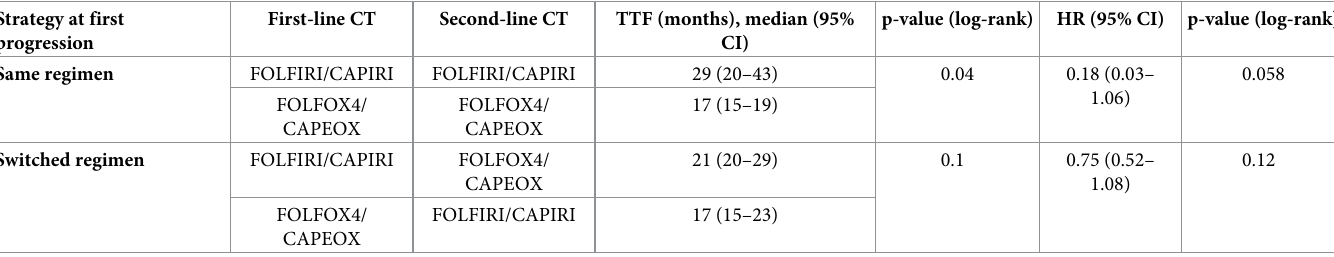
Table 5. Time to treatment failure according to the chemotherapy partner after first progression (same vs. switched regimens). Strategy at first